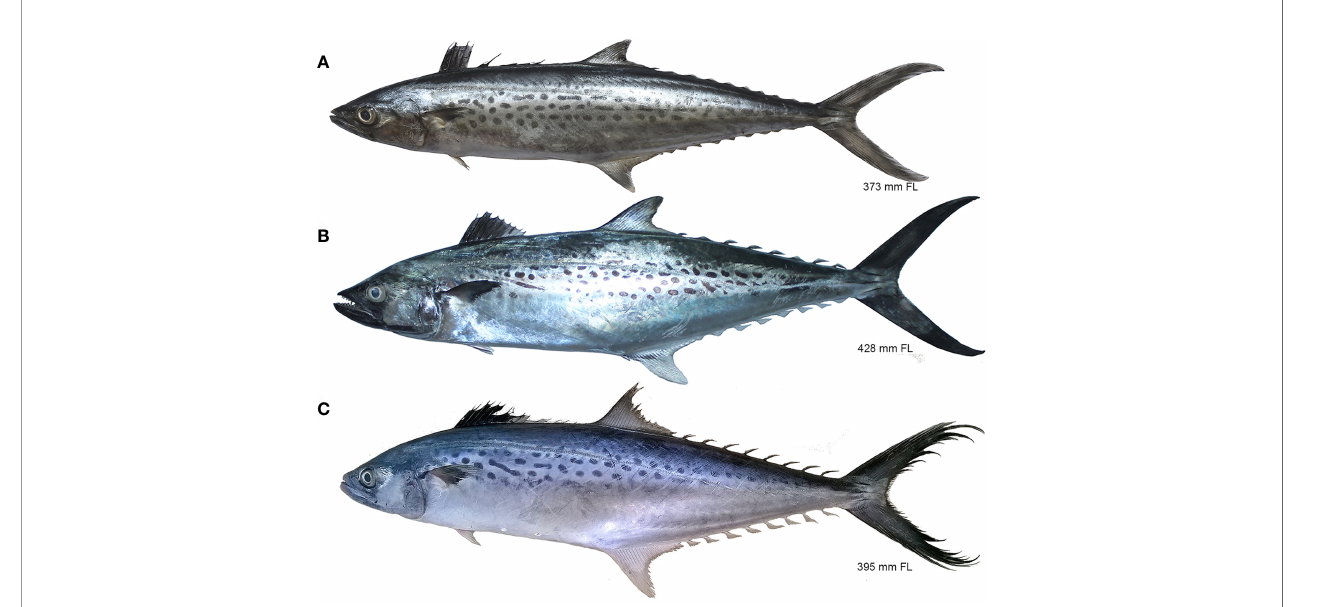
FIGURE 8 | Images of (A) Scomberomorus guttatus , collected from Tranquebar, India; (B, C) Scomberomorus leopardus (= S. aff. guttatus 1 and S. aff. guttatus 2, respectively) resurrected in this study. FL indicates fork length of the